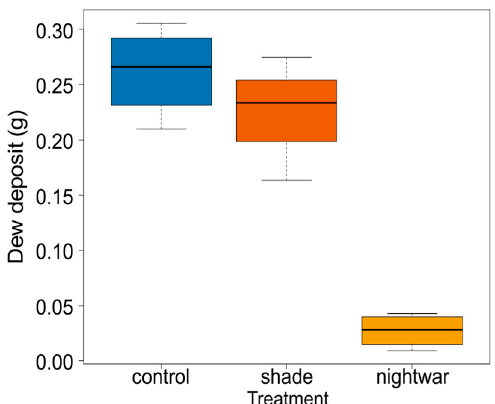
Figure A1. Dew deposit (in g) on a morning with heavy dewfall on flat white plastic temperature-sensor sunshields (ca. 5-cm diameter) at 10 cm above the soil surface in three sky-exposure treatments near the treeline in the French Alps. Boxplots show medians, quantiles, and minimum and maximum values, n = 4 sunshields. Treatments: control (no roof), shade (shade roof during the day), and nightwar = night warming (shade roof during the night).